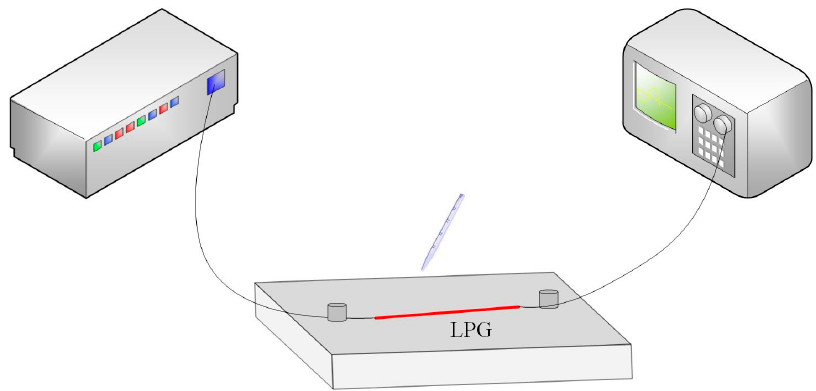
Figure 6. Schematic diagram of refractive index measurements.